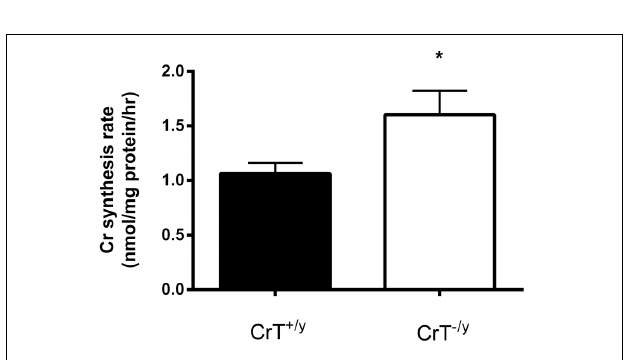
FIGURE 3 | In vitro creatine synthesis rates in gastrocnemius muscle of CrT + / y and CrT − / y mice. Values are means ± s.e.m., n = 7 per CrT − / y group and n = 10 per CrT + / y group. Different from CrT + / y ∗ P = 0 .